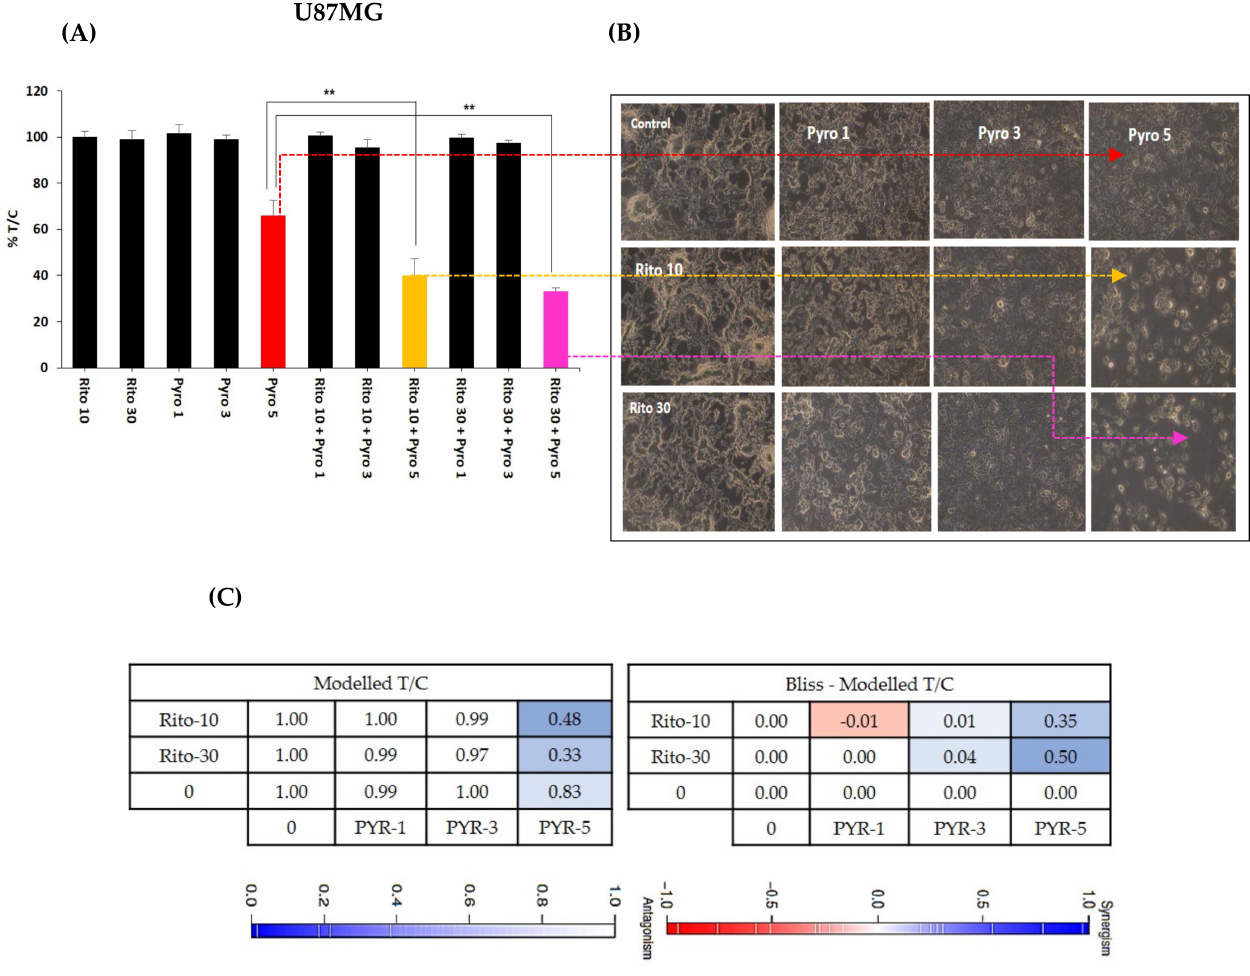
Figure 6. ( A ) Histograms showing the combined effect of Ritonavir (10 and 30 µ M) with PYR at 1, 3, and 5 µ M in U87MG, ** p ≤ 0.01. ( B ) Photomicrographs showing apoptotic population and changed morphology in U87MG cells when treated with PYR and Ritonavir. ( C ) A combination of PYR and Ritonavir was evaluated using BI analysis. Bliss index is shown as the difference between the expected T/C value (Bliss neutral) and the measured T/C value (modeled T/C) on a scale ranging from − 1.0 to 1.0. Positive values (Bliss Index ≥ 0.15, blue) indicate synergy, negative values (Bliss Index ≤ − 0.15, red) indicate antagonism, and zero is the neutral value